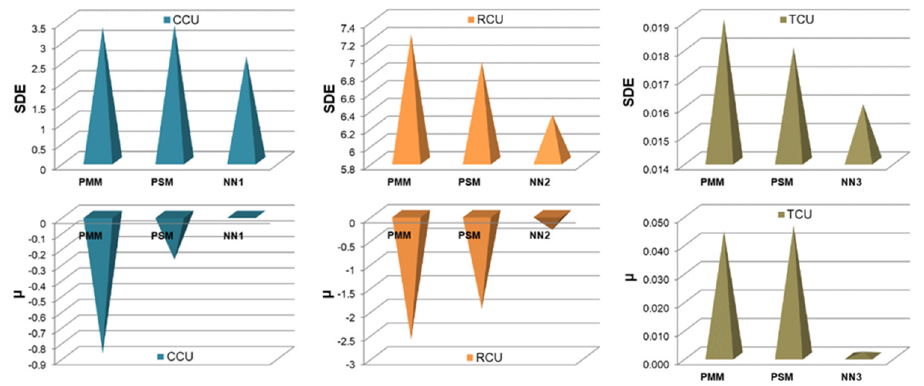
Figure 25. Comparison of fuzzy and ANN modeling results: SDE and μ.